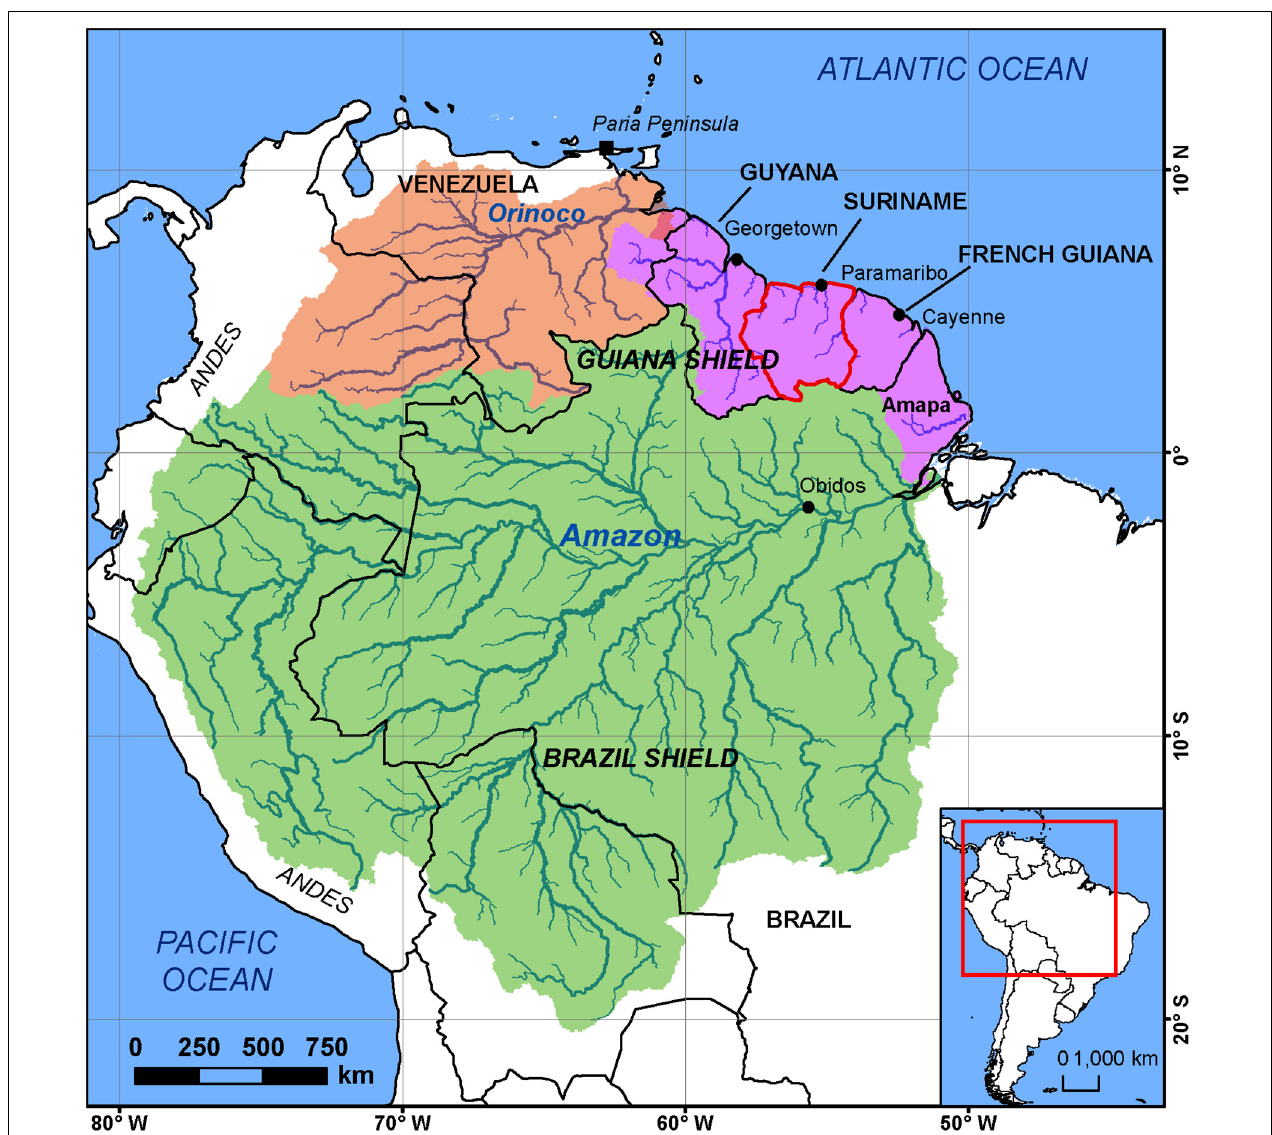
FIGURE 1 | Map of Suriname and the Amazon-Orinoco coast and the drainage basins of the Amazon and Orinoco Rivers and, collectively, the smaller Guiana Shield rivers between Amapá, in Brazil, and